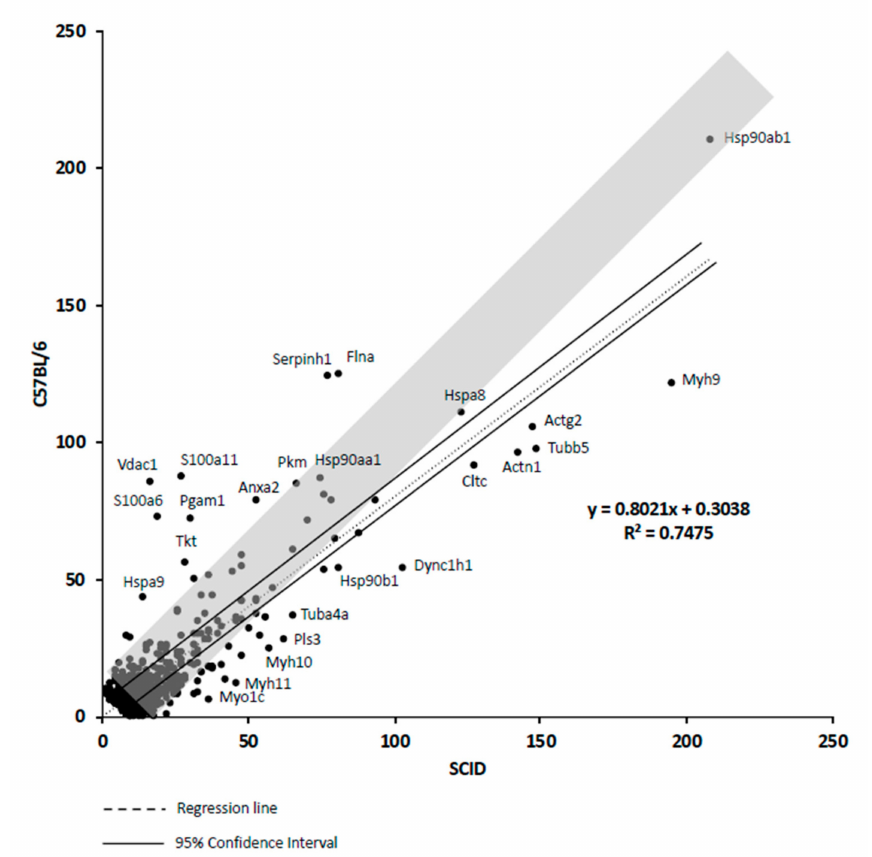
Figure 5. Correlation analysis: A scatter plot showing the correlation (R2 = 0.7475; gray band indicates “R2 = 1”) between the normalized values of proteins expressed by C57BL / 6 mAdMSCs and SCID mAdMSCs (n = 622). The parallel lines indicate the 95% confidence